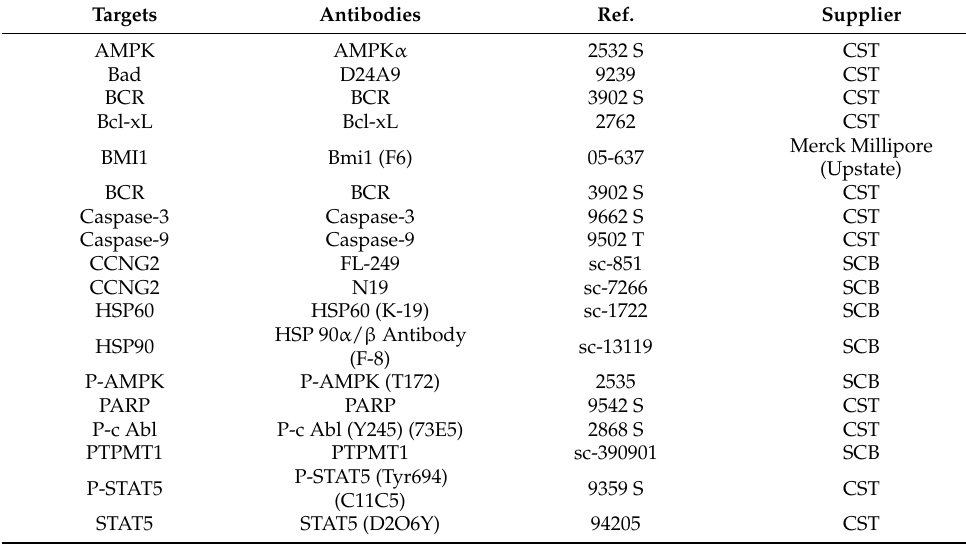
Table 1. Antibodies used in Western blot